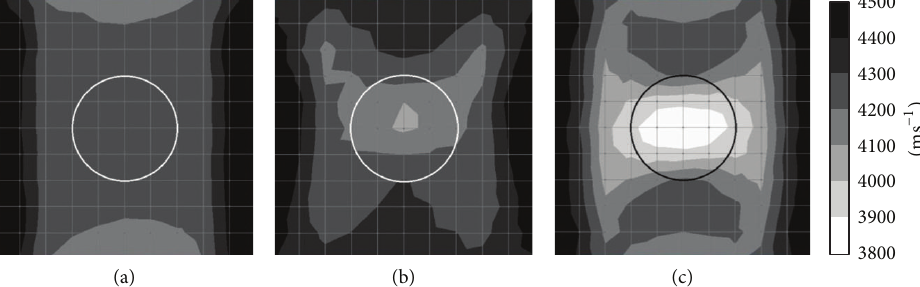
Figure 6: Tomograms of model with a total number of 12 sensors attached to left and right side: (a) 0% void; (b) 50% void; (c) 100% void.